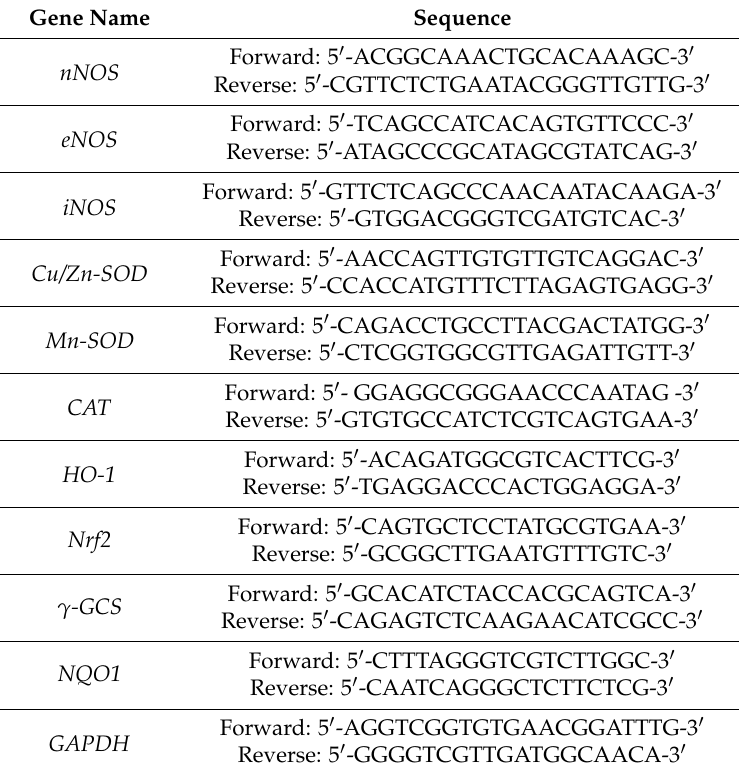
Table 5. Sequences of primers used in this